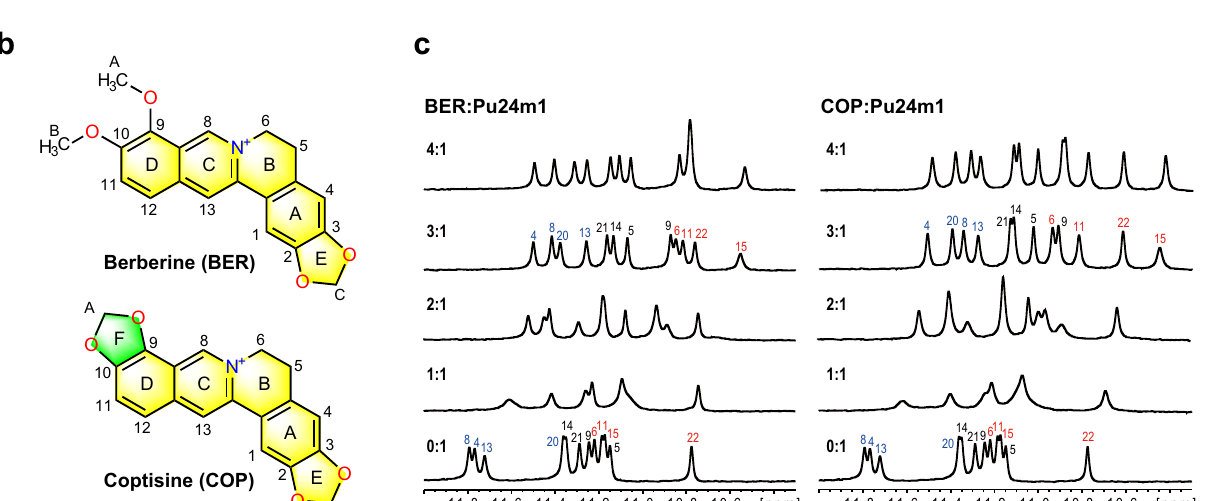
Fig.1| KRAS -G4anditsinteractionwithberberineandcoptisine.a Schematicof the human KRAS gene promoter and the formation of a KRAS -G4 as well as its complex with small molecules (ligands). The G4-forming region of the NHE sequenceisshown.TheG-tractsimplicatedin KRAS -G4formationaremarkedinred